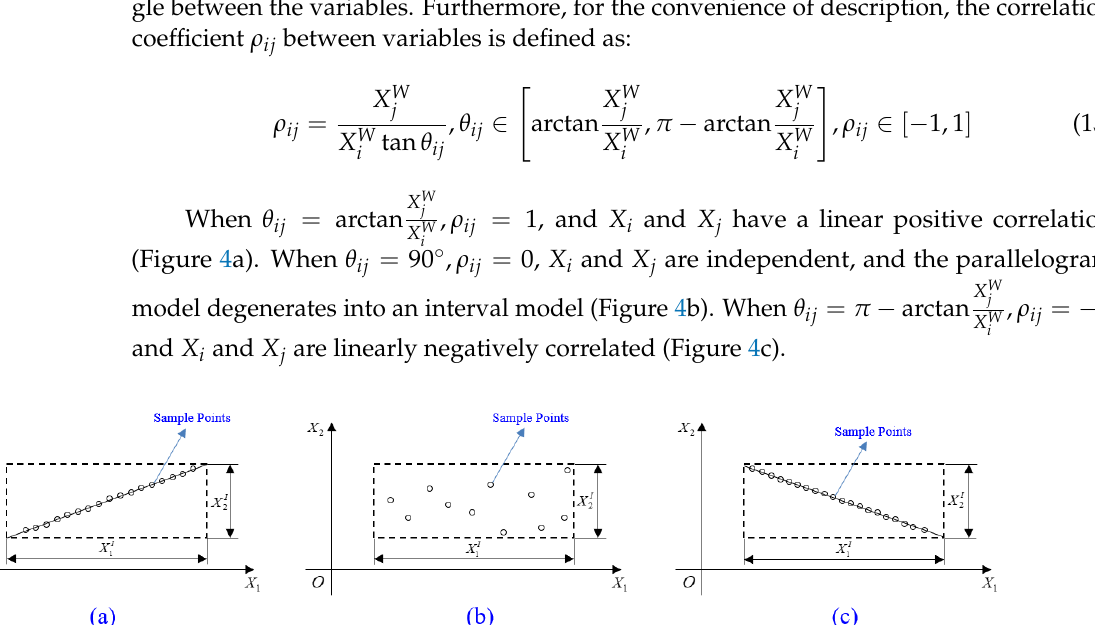
Figure 4. Parallelogram models for three typical correlation coefficients. ( a ) Positive Correlation, ρ 12 = 1; ( b ) Independent, ρ 12 = 0; ( c ) Negative Correlation, ρ 12 = −1.